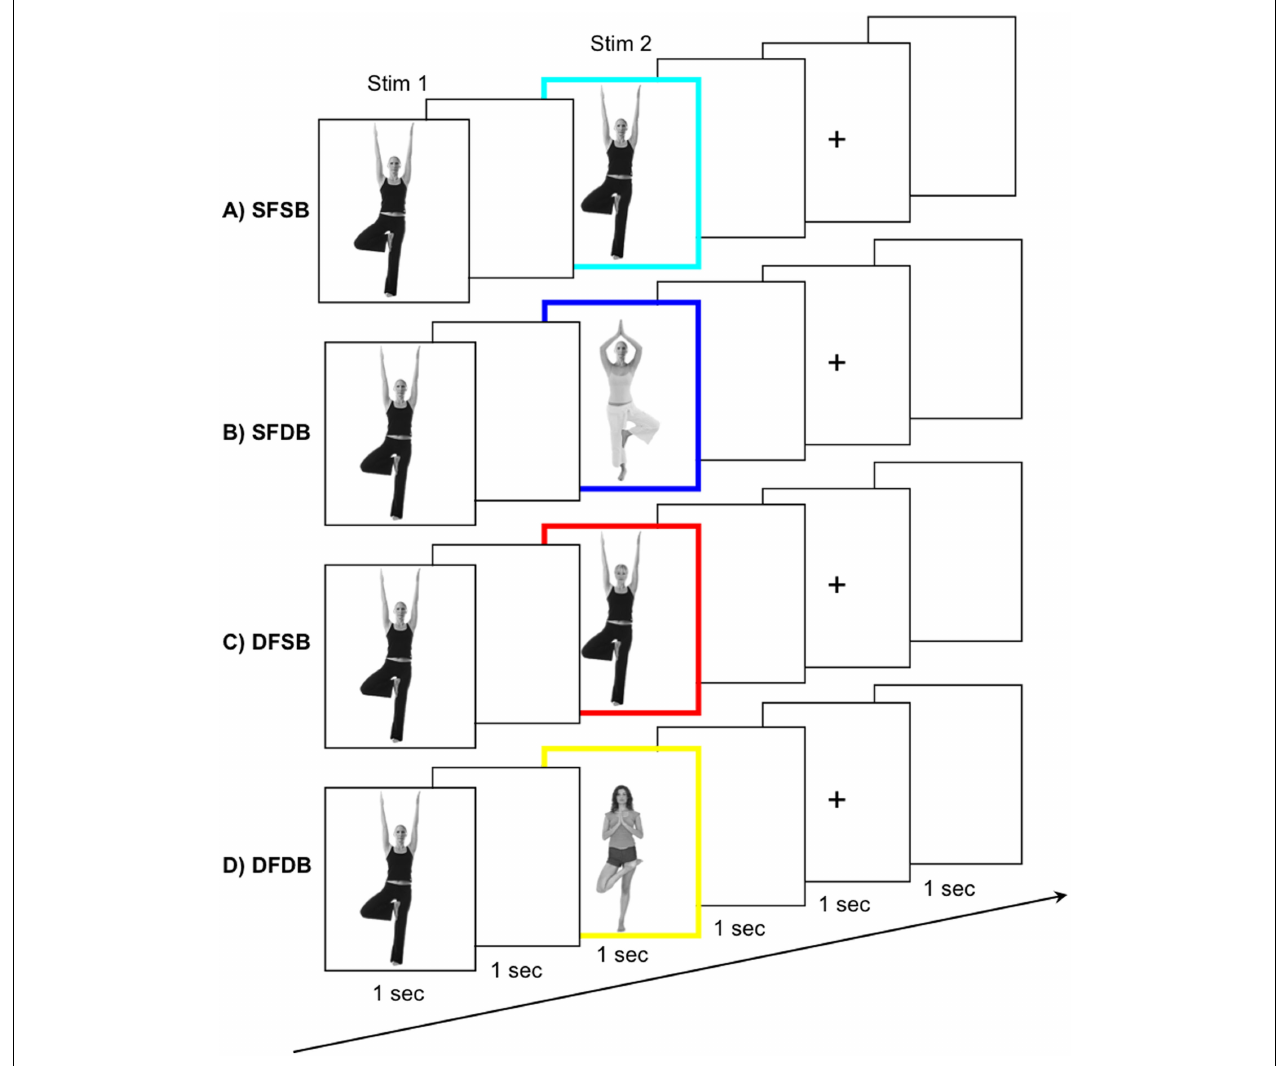
repeat of the same body (DFSB); and (D) both a different face and different body (DFDB).To ensure maintenance of attention to both the face and the body of the experimental stimuli, participants were instructed to press a button whenever they detected a specific target face or body, which occurred on 10% of the